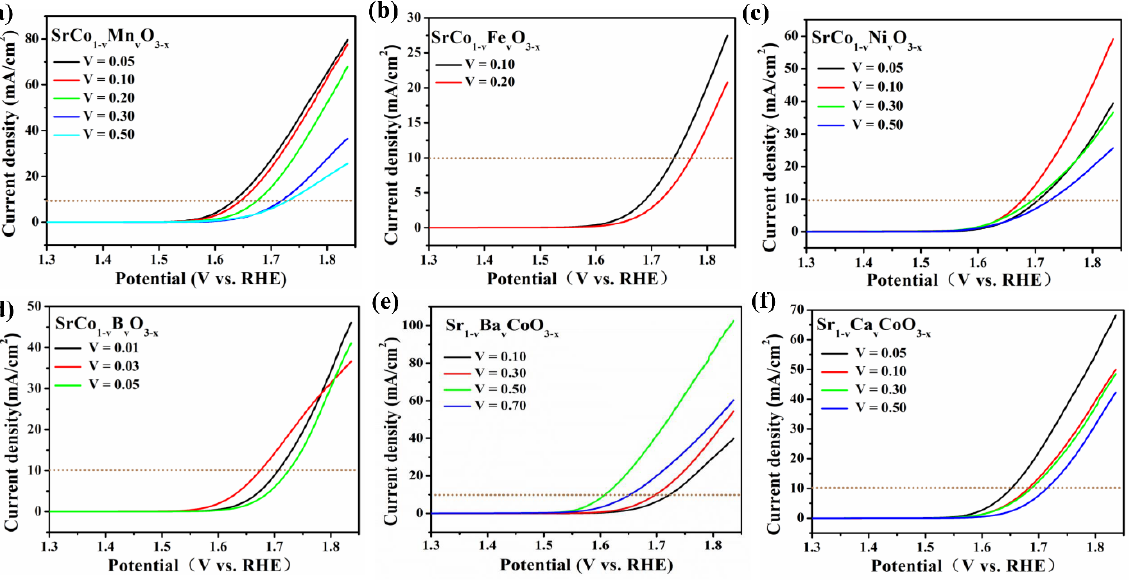
Figure 4. LSV patterns of Sr − v A v Co b O 3 − x and SrCo 1 − v R v O 3 − x [R = ( a ) Mn; ( b ) Fe; ( c ) Ni; ( d ) B; A = ( e ) Ba; ( f ) Ca]. A = ( e ) Ba; ( f )